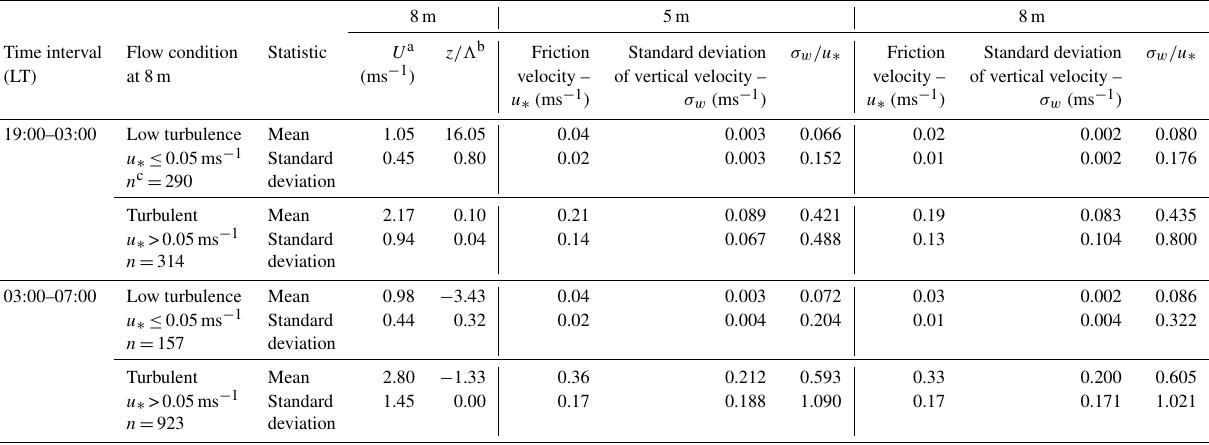
Table 2. Wind conditions over the maize canopy. Statistics based on 30min averaging period of 10Hz 3-D sonic anemometer measurements at indicated heights over the entire study period.